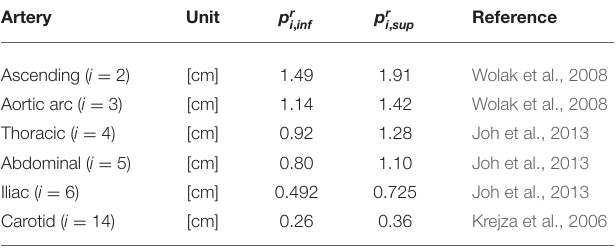
TABLE 4 | Summary of the ranges for the arterial radii utilized in this study. Artery